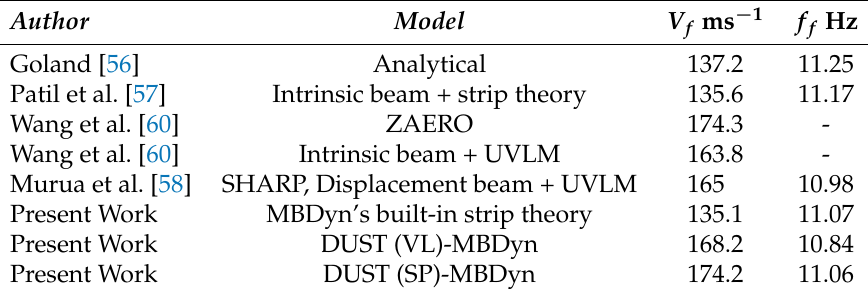
Table 3. Comparison of flutter speed and frequency computed for Goland’s